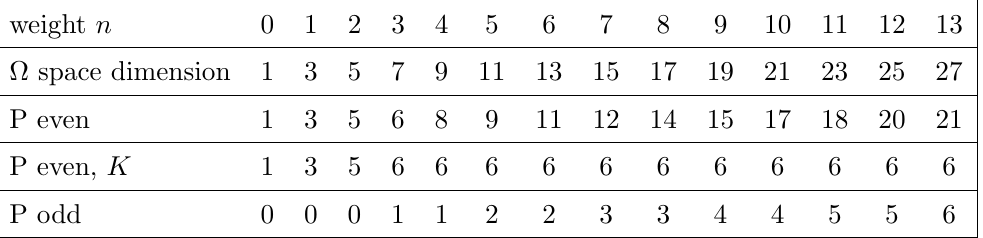
Table 3 . Dimension of the full weight- n (cid:10) space, and decomposed into even and odd subspaces under parity P. In the P-even sector we also list the number of K functions, which have no y u ; y v ; y w letters in their